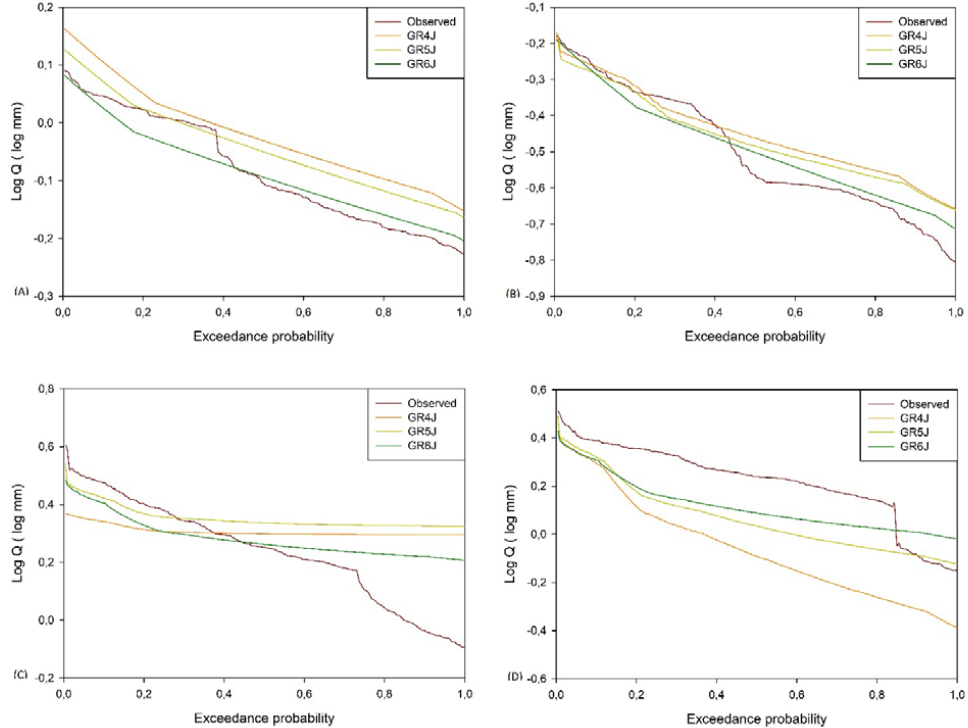
Figure 9. Low-flow exceedance probability curves for observed and simulated values by the GR4J, GR5J and GR6J hydrological models in the validation period for: Q2 ( A ), Q3 ( B ), BLQ1 ( C ) and BLQ2 ( D ), in south-central Chile.